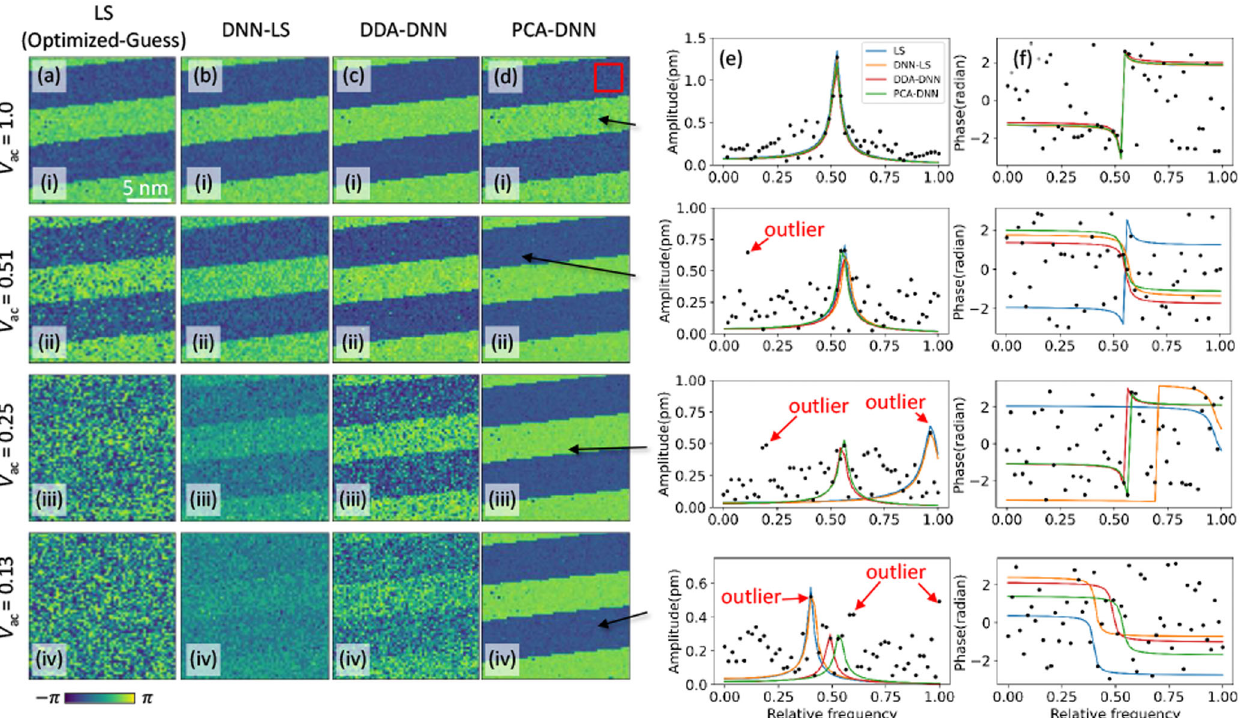
Fig. 3 Comparison of the fi tted and predicted SHO phase images for the actual dataset of PPLN. The dataset was acquired using the V ac amplitude sweep measurement with maximum V ac = 1 V: phase images of ( a ) optimized LS, ( b ) DNN-LS, ( c ) DDA-DNN, and ( d ) PCA-DNN at different V ac steps of (i) 1.0 V ac , (ii) 0.51 V ac , (iii) 0.25 V ac , and (iv) 0.13 V ac , respectively. e , f Raw data points and corresponding fi tted and predicted lines of different methods for ( e ) amplitude and ( f ) phase. The black and red arrows in ( d , e ) are the exact pixels of the raw data and the data outlier that could induce poor fi tting of the LS and DNN-LS, respectively. We note that the PCA-DNN was denoised using 1